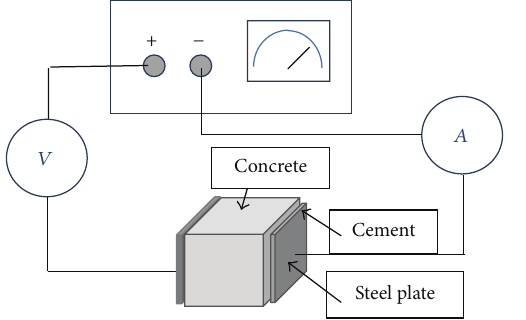
Figure 3: Electrical resistance measuring setup.